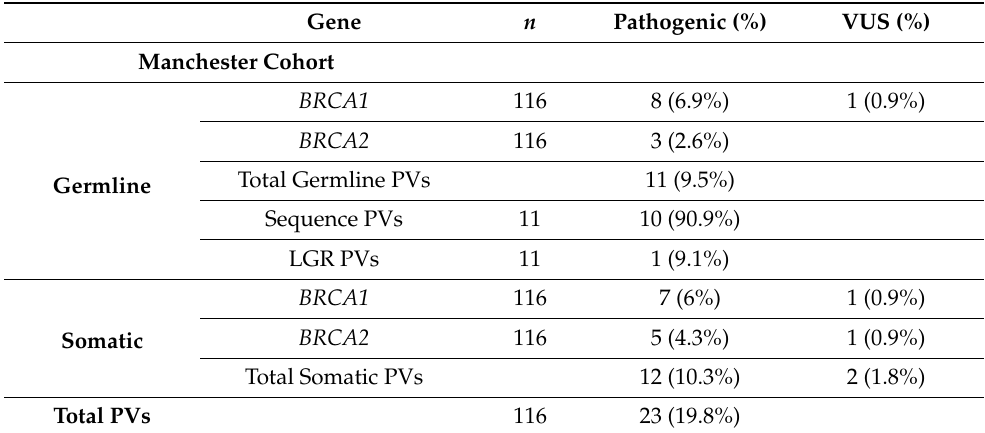
Table 5. Mutation Prevalence (Manchester